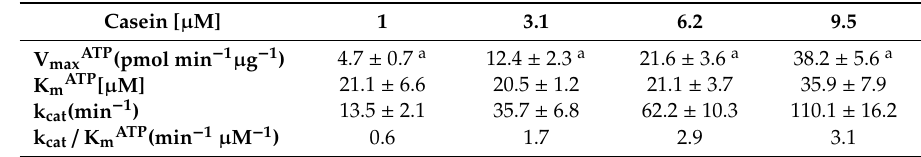
Table 1. Kinetic parameters values of CK1 ε as a function of varying ATP concentrations at fixed casein amounts.